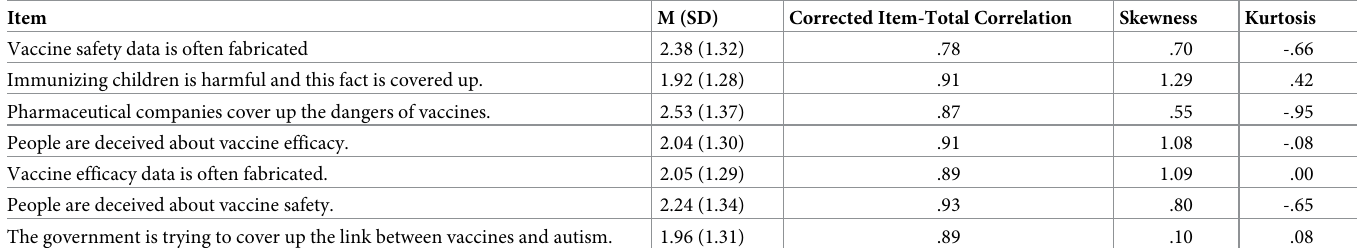
Table 1. Descriptive statistics for the vaccine conspiracy beliefs scale. Item M